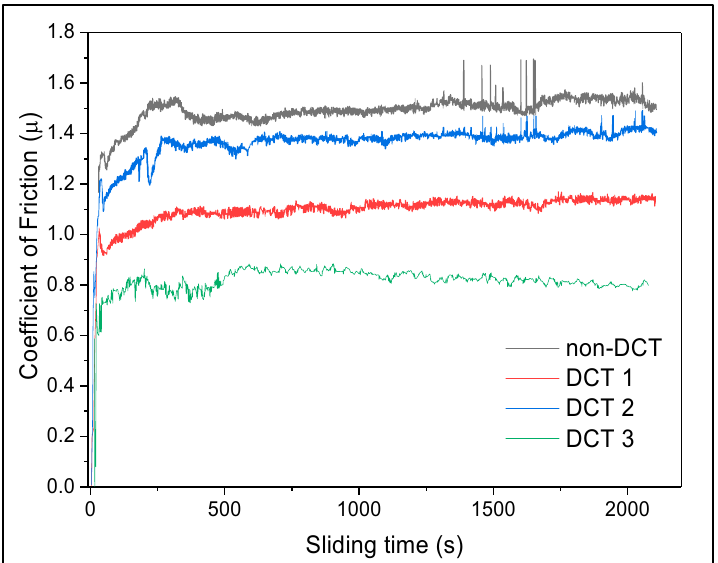
Figure 3. CoF data with 30 N load on all 4 samples.